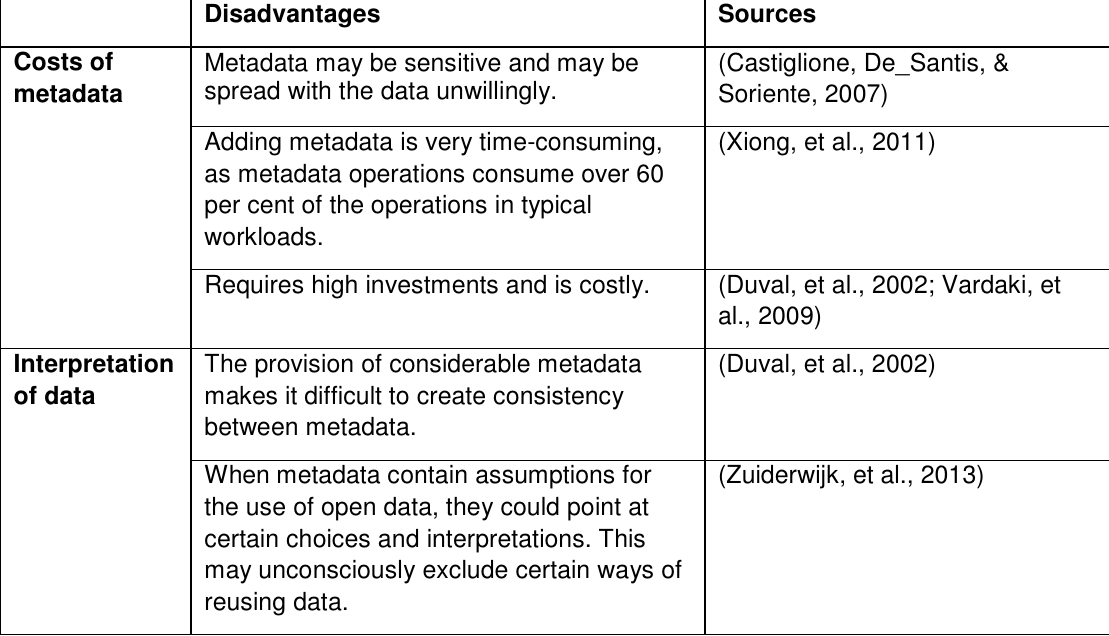
Table 3: Overview of disadvantages of metadata, derived from